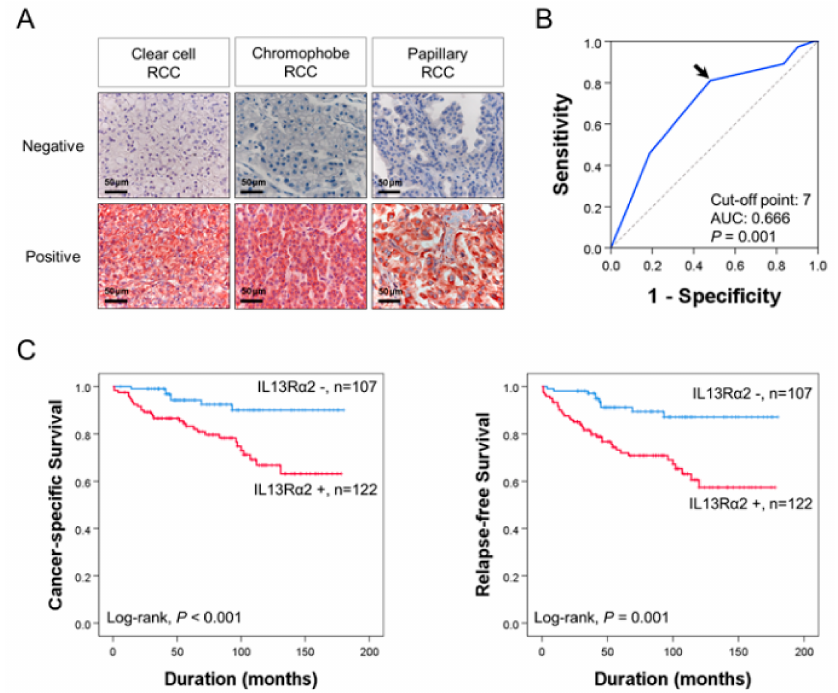
Figure 1. Immunohistochemical expression and survival analysis for the expression of IL13R α 2 in renal cell carcinomas. ( A ) Immunohistochemical expression of IL13R α 2 in clear cell renal cell carcinoma, chromophobe renal cell carcinoma, and papillary renal cell carcinoma tissue. Original magnification, × 400. ( B ) Receiver operator characteristic curve analysis to determine the cutoff point of IL13R α 2 immunostaining. The cutoff point is determined to predict cancer-specific survival of renal cell carcinoma patients. The cutoff point has the highest area under the curve (AUC). Arrow indicates a cutoff point for the IL13R α 2 immunostaining. ( C ) Kaplan–Meier survival analysis for cancer-specific survival and relapse-free survival according to the immunohistochemical positivity for IL13R α 2 in 229 cell renal cell